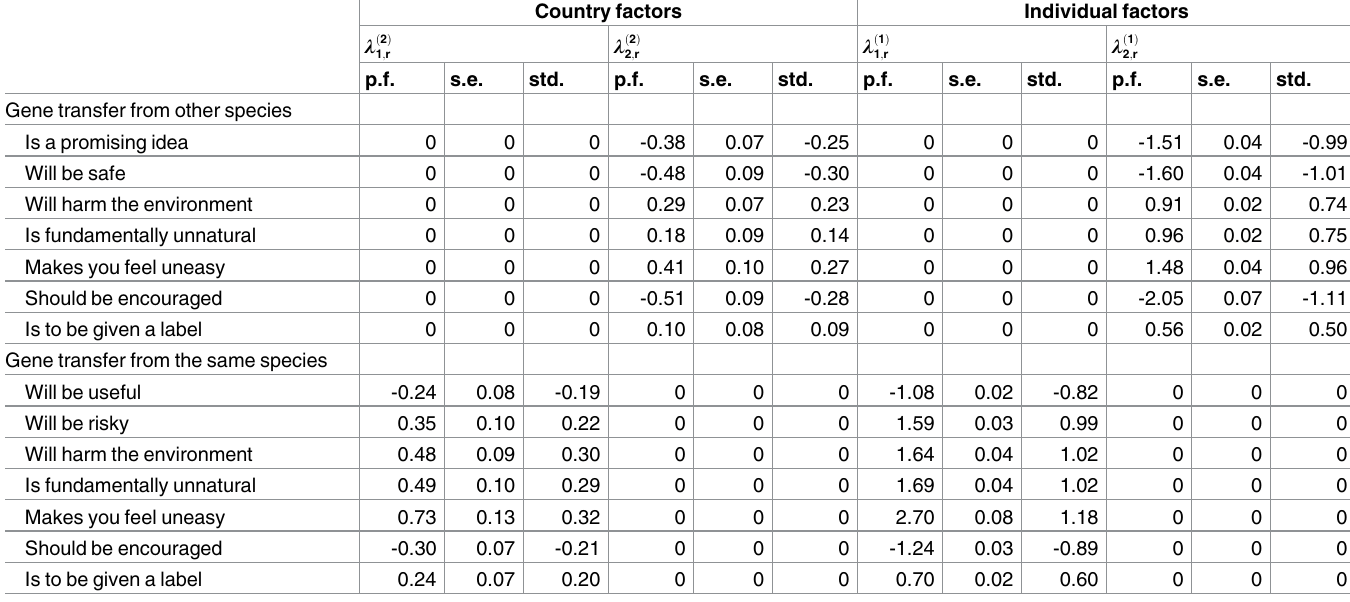
Table 5. Estimation of